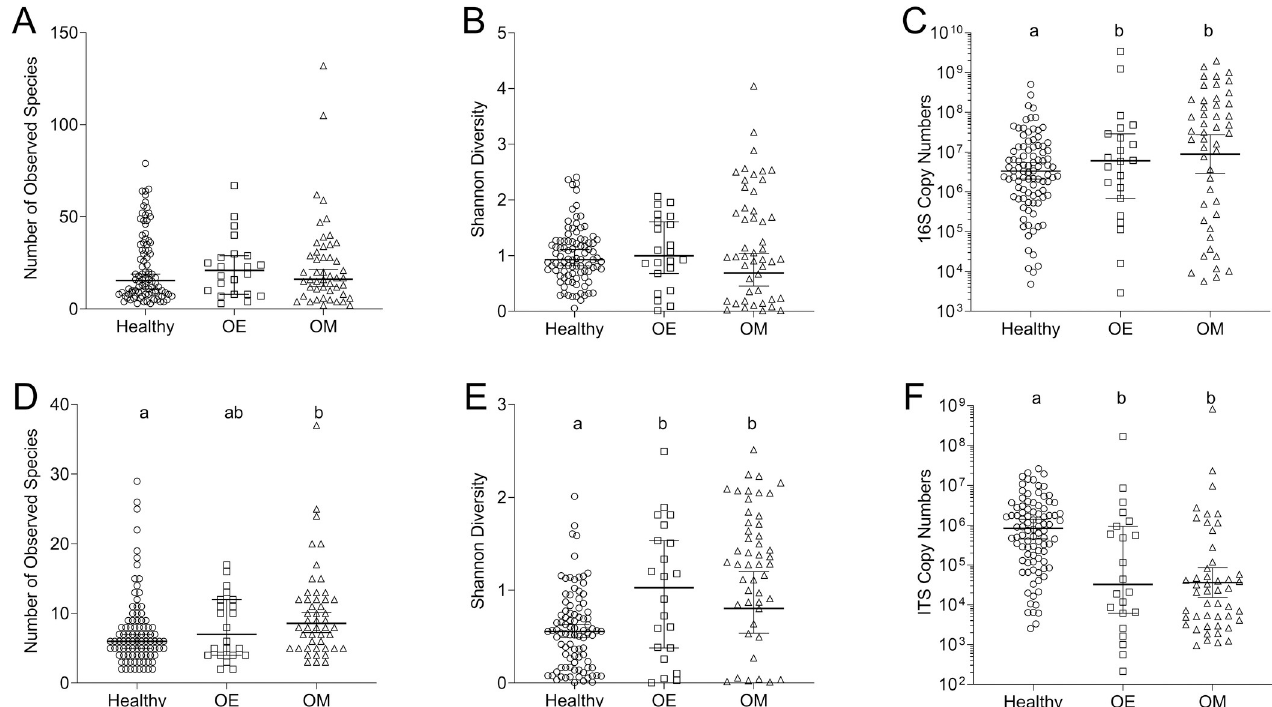
Fig 2. Diversity analysis between groups for bacteria (A-C) and fungi (D-F). Alpha diversity was determined by the number of observed species (A and D) and the Shannon diversity index (B and E). Estimations of the bacterial (C) and fungal (F) biomass were done based on 16S and ITS copy numbers, respectively. Letter (a, b) highlight groups that were significantly different from each other (P >